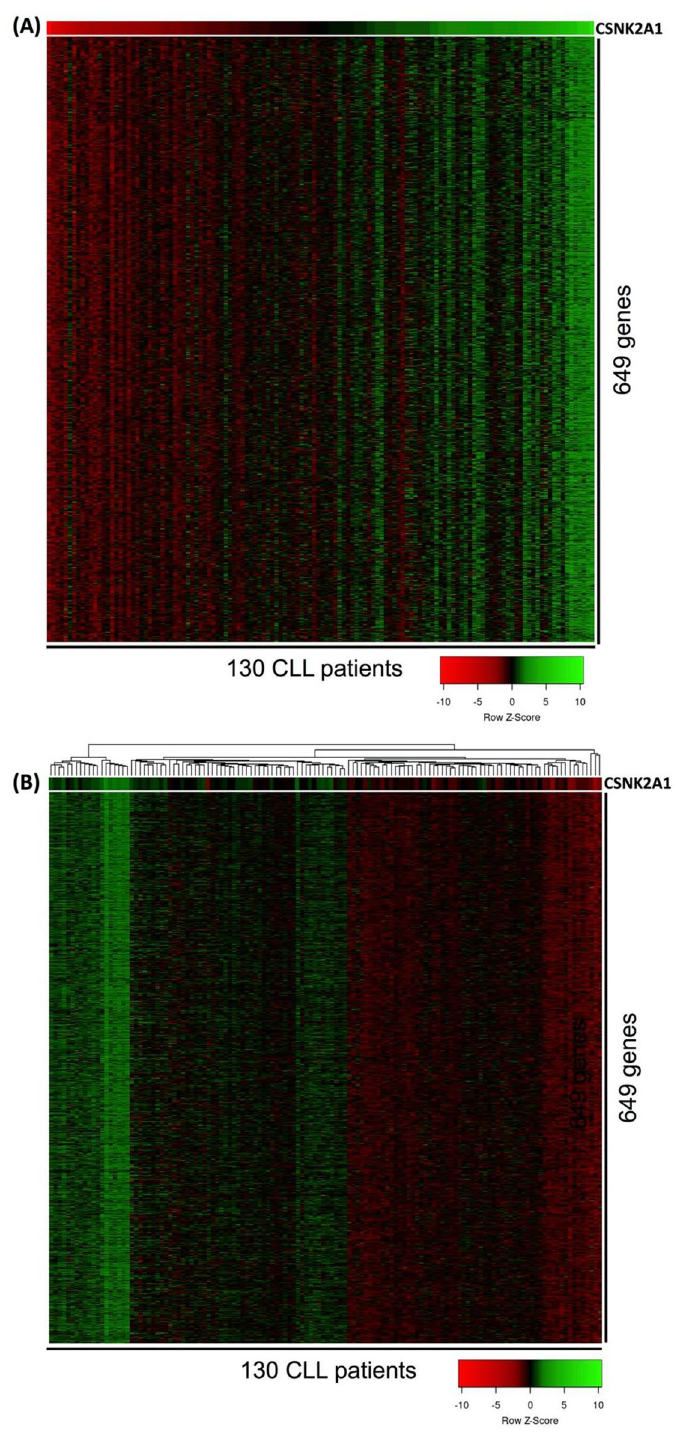
Figure 2. Heatmap presentation of the correlation between the expression of CSNK2A1 and the expression of other genes from the entire transcriptome of CLL cells in 130 patients. In ( A ) the 130 patients were sorted according to the expression of CSNK2A1 (top gene) from least expression (red color) to the highest expression (green color). From the whole transcriptome of CLL cells, a total of 649 genes were found to have their expression correlated with the expression of CSNK2A1 in the 130 patients (Pearson score = 0.60–0.81; p value < 0.00001). Cluster analysis using average linkage method for clustering and Manhattan method for distance measurement clustered the 130 patients according the expression of CSNK2A1 and the 649 genes ( B ). The CLL transcriptomics data set used in this analysis was GSE39671. Color legend: red is low expression and green is high